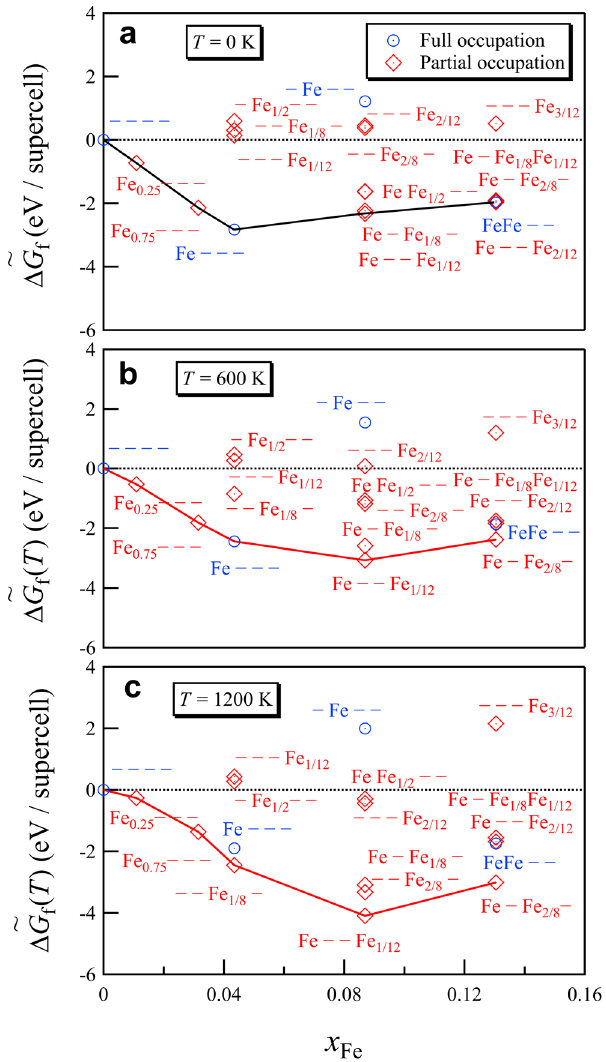
Figure 4. The free energy of formation, Δ  G T = 600 K and ( c ) T = 1200 K. The open circles (diamonds) indicate the results from full (partial) site occupation